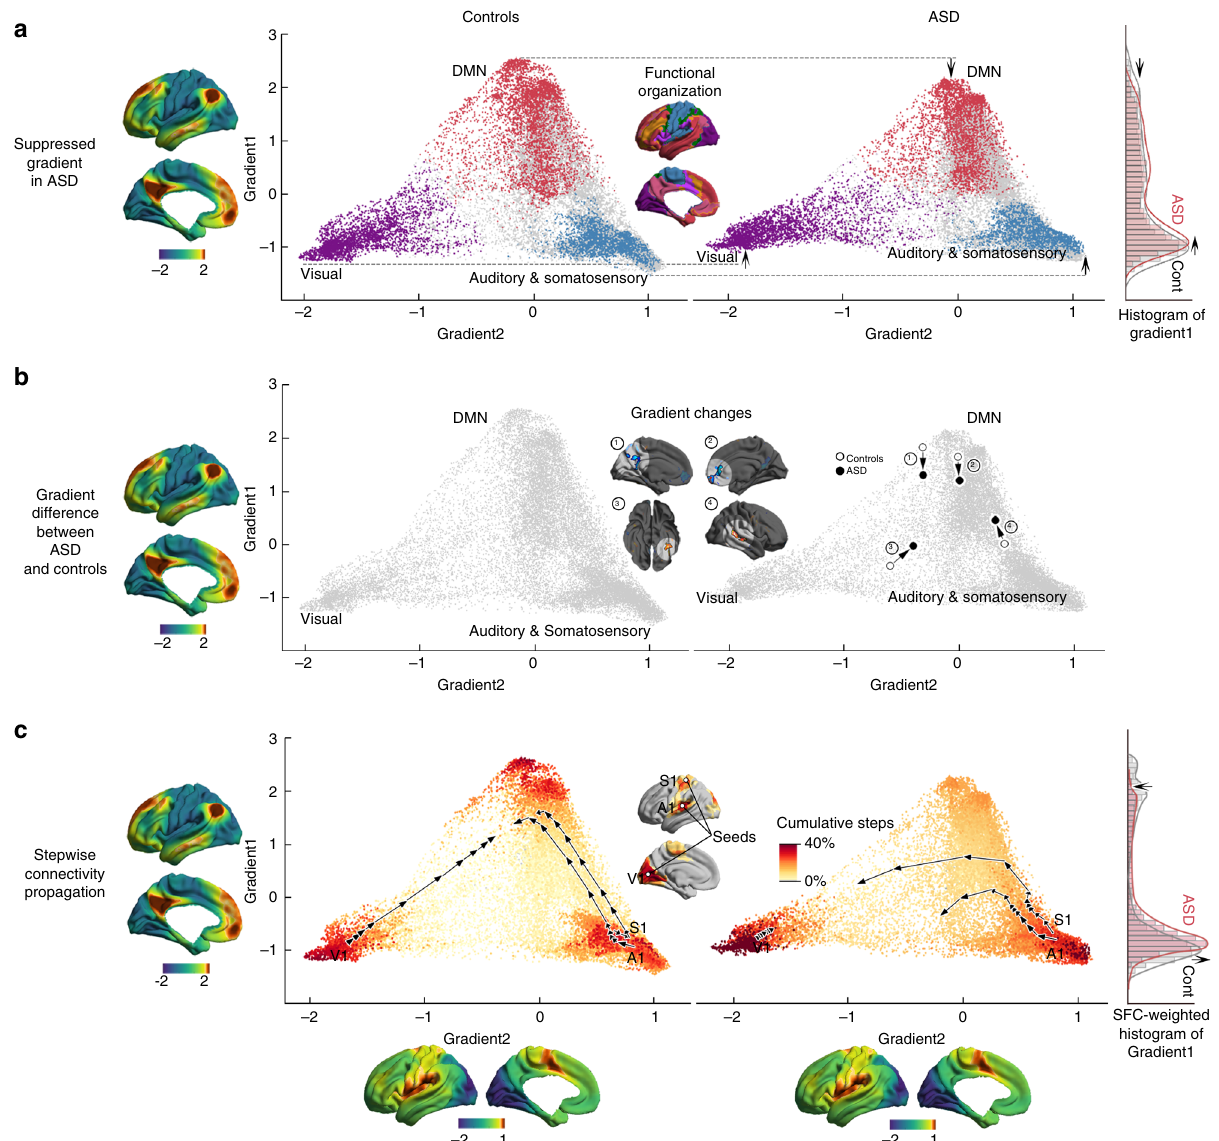
Fig. 3 Integration of gradient and SFC fi ndings. a Scatter plot of the fi rst two connectivity embedding gradients in controls and ASD. Gradient 1 ( y -axis) runs from primary sensorimotor ( dark turquoise ) to transmodal DMN ( sienna ). Gradient 2 ( x -axis) separates somatomotor and auditory cortex from visual cortex. Triangular scattered points are colored with respect to established functional communities 18 . Histograms on right show the point density in ASD (light red) and controls (gray), suggesting overall compression of the fi rst gradient in ASD. b Post-hoc analysis, showing positional shifts of the four signi fi cant clusters from the surface-based analysis (See Figure 1; 1-PCC/PCU, 2-mPFC, 3-OT, 4-pMTG). c Stepwise functional connectivity (SFC) in gradient space. Points are colored with respect to cumulative steps when simultaneously seeding from V1, S1, and A1. Trajectories (sampled every 20th step) illustrate the direct SFC from the primary sensory seeds to transmodal DMN in controls (left). ASD show an initially more rapid transition; however, trajectories de fl ect from a straight path and do not reach the DMN, even after 200 steps. Histogram on the right show point densities, weighted by the cumulative SFC. See also Supplementary Movies 1 –